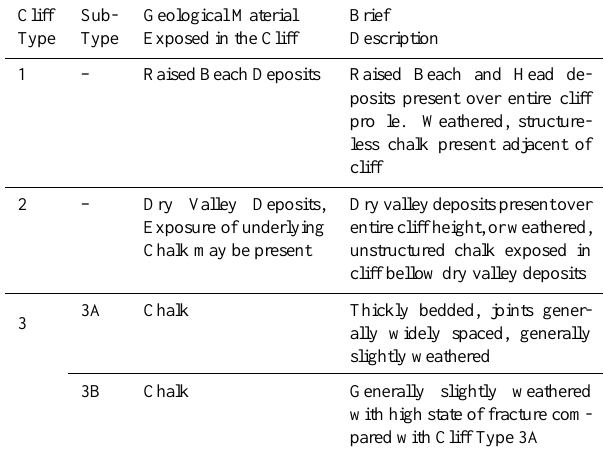
Table 1. Cliff Type Classification (High-Point Rendel, 1999, 2001,